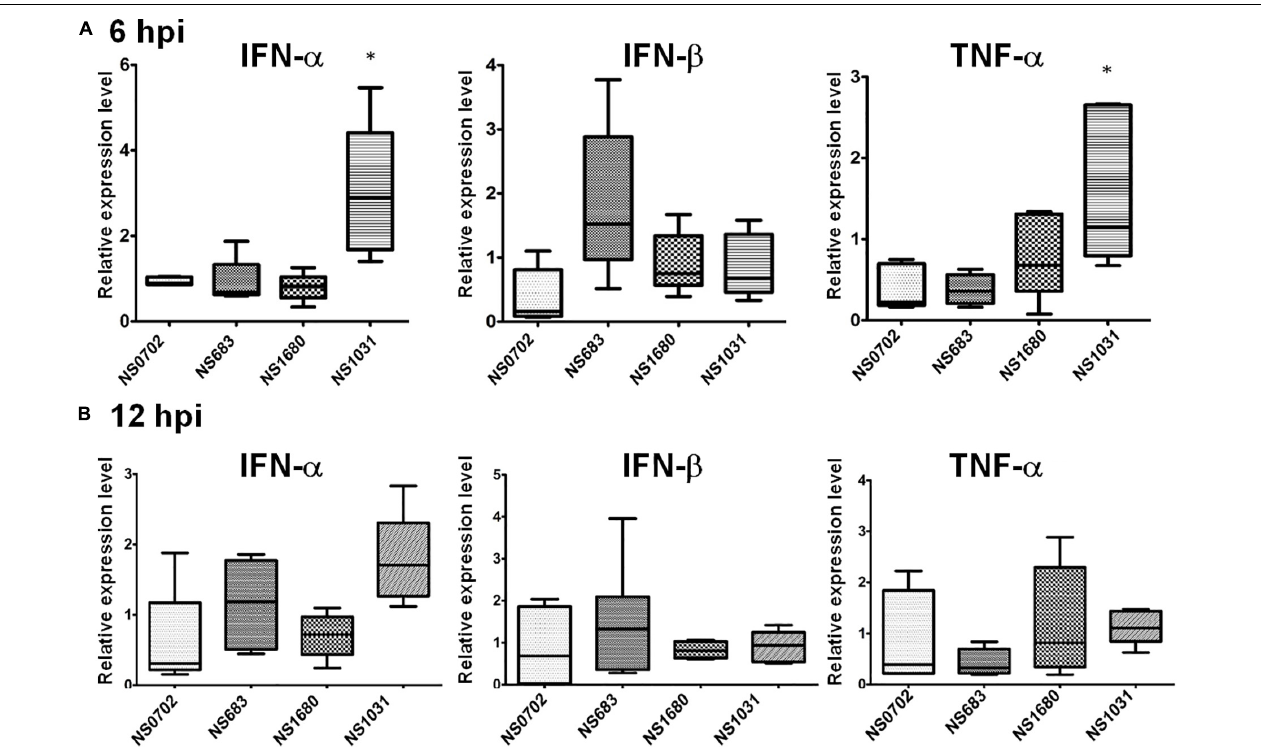
FIGURE 6 | Expression of cytokines in human cells infected with reassortant avian influenza viruses (AIVs). Human A549 cells were infected by reassortant AIVs at a multiplicity of infection (MOI) of 0.1. Total IFN- α , IFN- β , and TNF- α RNA were extracted at (A) 6 and (B) 12 hpi, and cytokines were quantified by qRT-PCR.